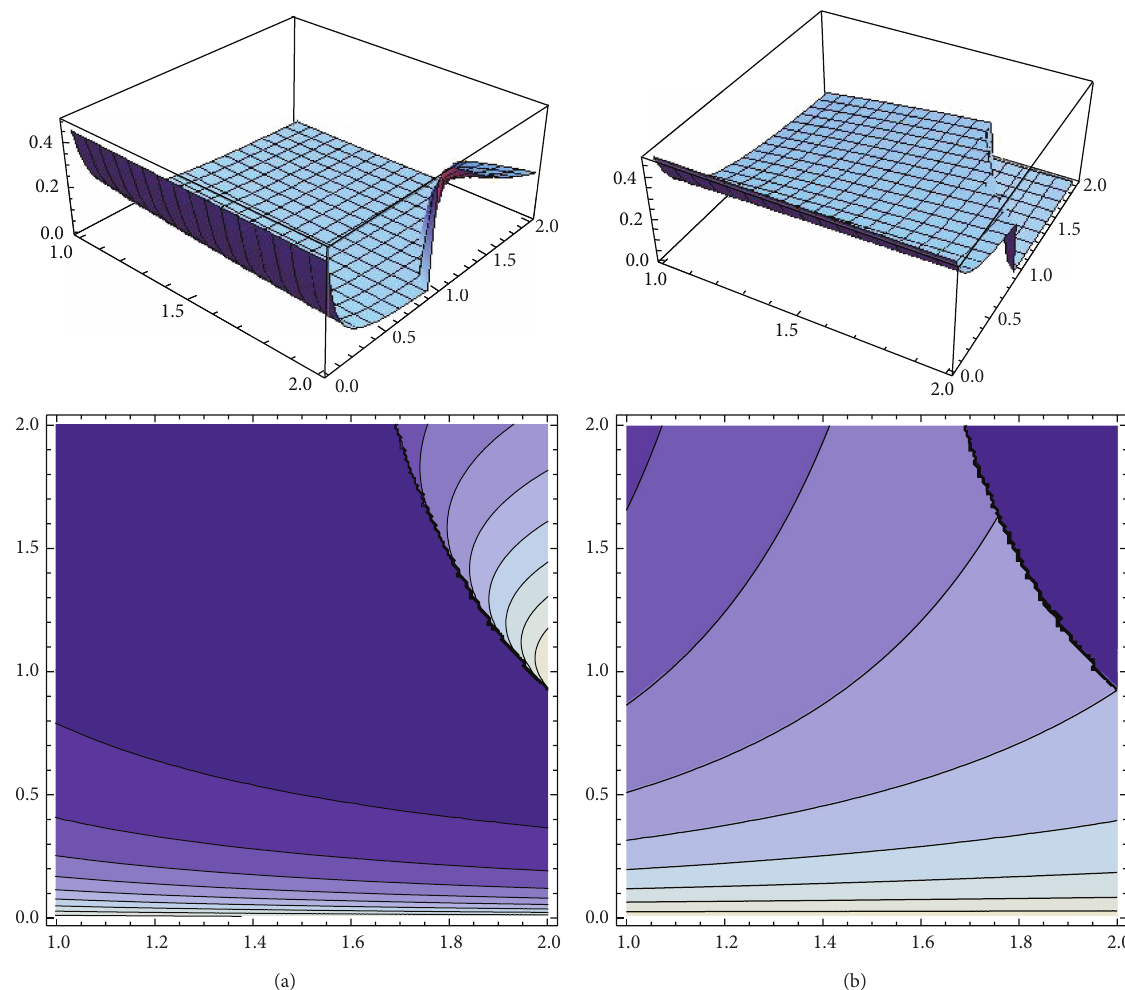
Figure 19: Average profits of firms 1 (a) and 2 (b) when we choose the fixed point which gives us the maximum profit of the first firm 1 among all the fixed points. Note that in projections, the darker the color is, the lower the profit is.